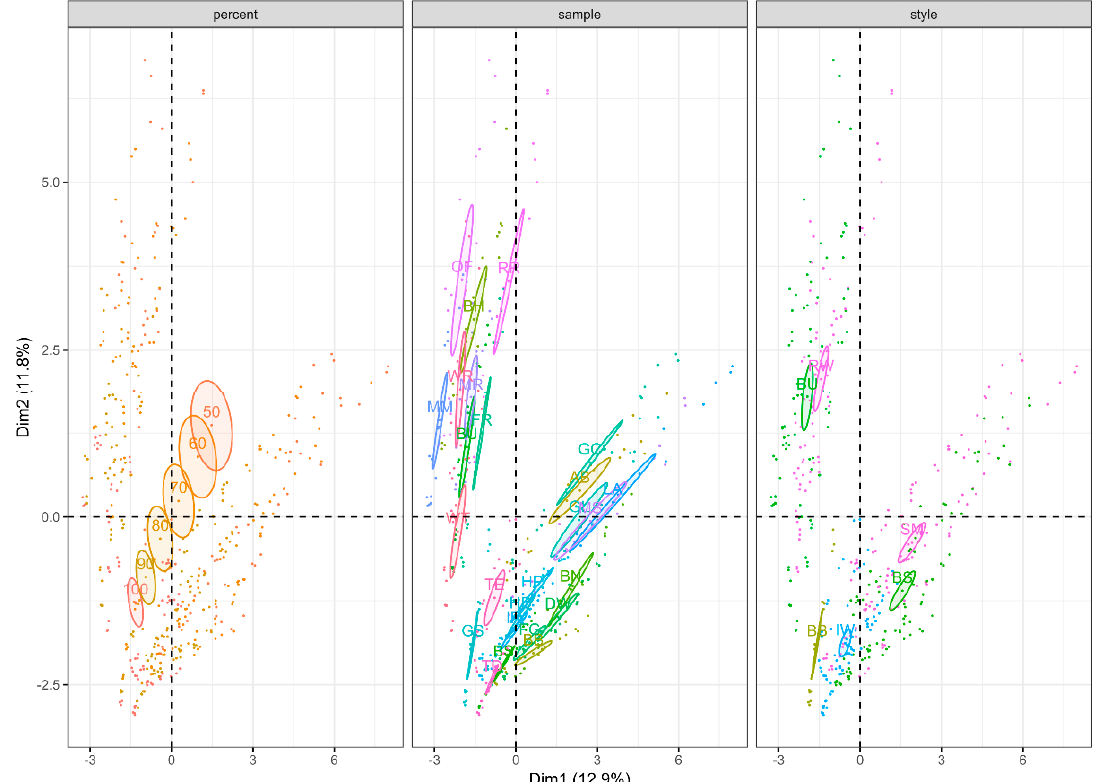
Figure 1. Multi factor analysis (MFA) of larger dataset of headspace volatile content of 25 whiskies consisting of five blended Scotch whiskies (BS), five Bourbons (BU), four Irish whiskeys (IR), four rye whiskeys (RW), six single malt Scotch whiskies (SM), one barrel strength Bourbon whiskey (BB), measured at six different dilution levels (100, 90, 80, 70, 60, and 50% whisky in purified water) in triplicate. Analysis was performed using nine groupings consisting of three categorical variables (percent whisky, style, and sample name) and 91 volatile compounds separated in to eight compound classes, tentatively identified by GC-MS using the NIST 2020 library. Ellipses represent a 95% confidence interval about the